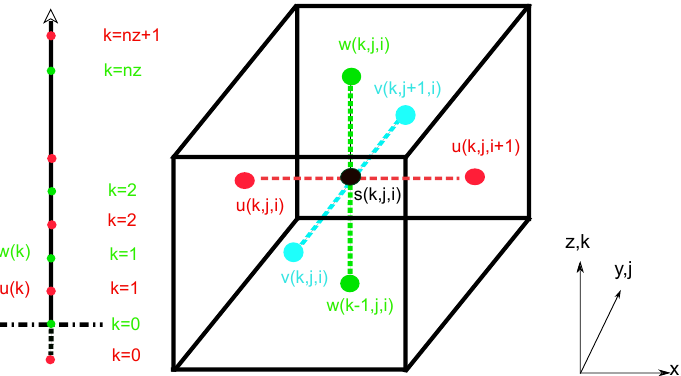
Figure 1. The Arakawa staggered